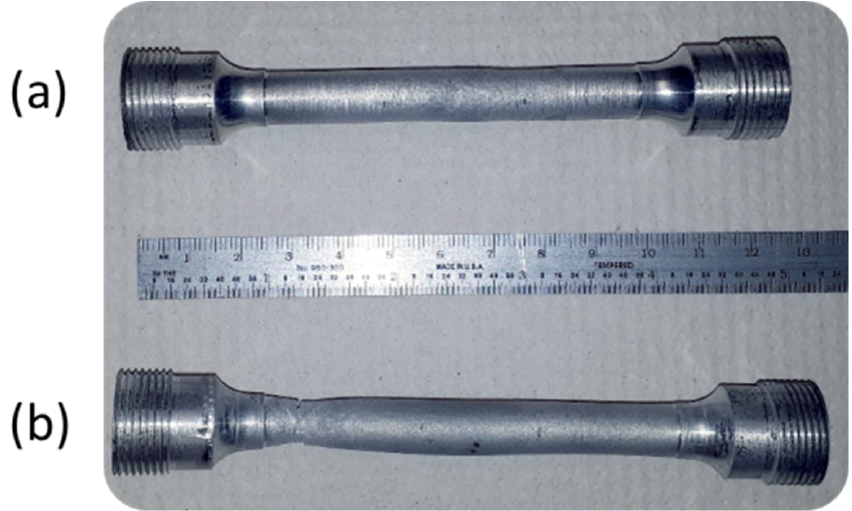
Figure 11. Gleeble 3800 OP-TMF test pieces after being tested until failure with a mechanical strain amplitude of 0.5% and a temperature cycling between 60 and 300 ◦ C. Aging condition ( a ) T7, and ( b )